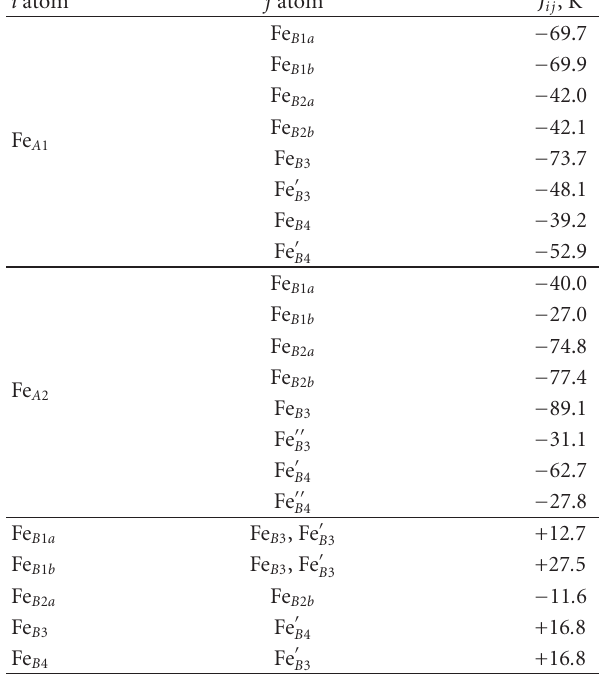
Table 2: Exchange couplings J ij (all with | J ij | > 10 K) are presented [155]. The values are given in Kelvin. The spatial representation of the Fe B –Fe B exchange couplings is schematically shown in Figure 12. J ij were calculated between the sublattices formed by the translations of the following Fe sites: Fe A 1 (1/4,0.0034,0.06366), Fe A 2 (1/4, − 0.4938,0.18867), Fe B 1 a (0,1/2,0), Fe B 1 b (1/2,1/2,0), Fe B 2 a (0,0.0096,1/4), Fe B 2 b (1/2,0.0096,1/4), Fe B 3 ( − 1/4,0.2659,0.1198), Fe (cid:2)